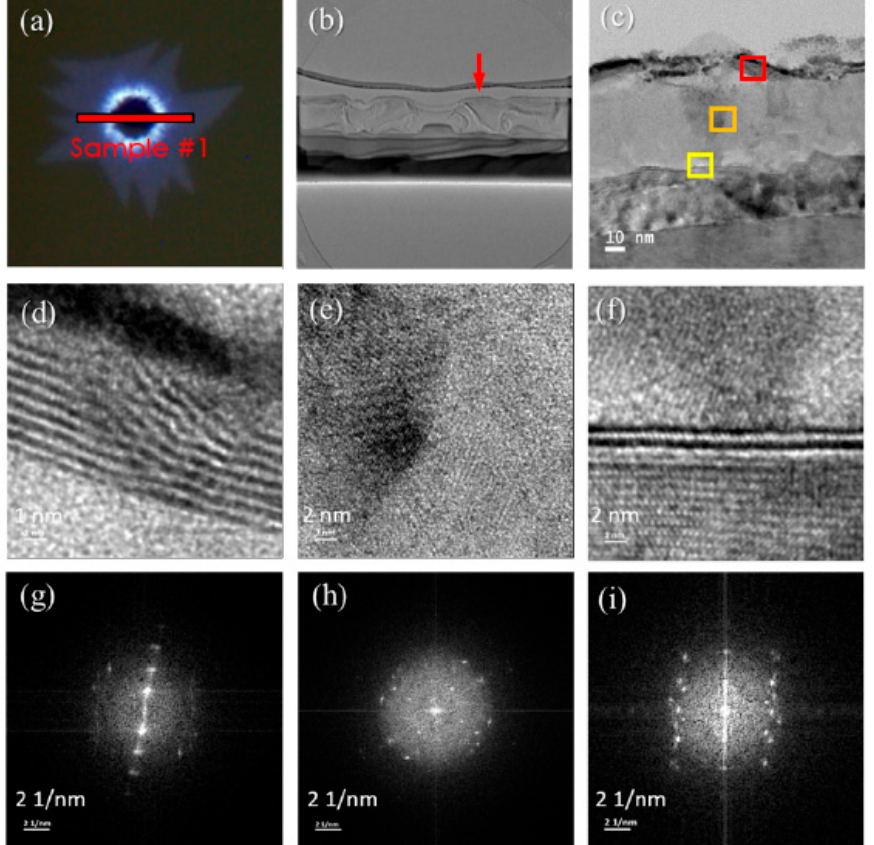
Figure 6. Panel ( a ) is the OM image after growing MoS2, ( b ) is the cross-sectional TEM image of the selected area in ( a ), ( c ) is the enlarged TEM image of the red arrow in ( b ). Panels ( d – f ) represent the HRTEM images of the red, orange, and yellow boxes in ( c ), respectively, and ( g – i ) represent the SAED diagrams in ( d – f ), respectively.